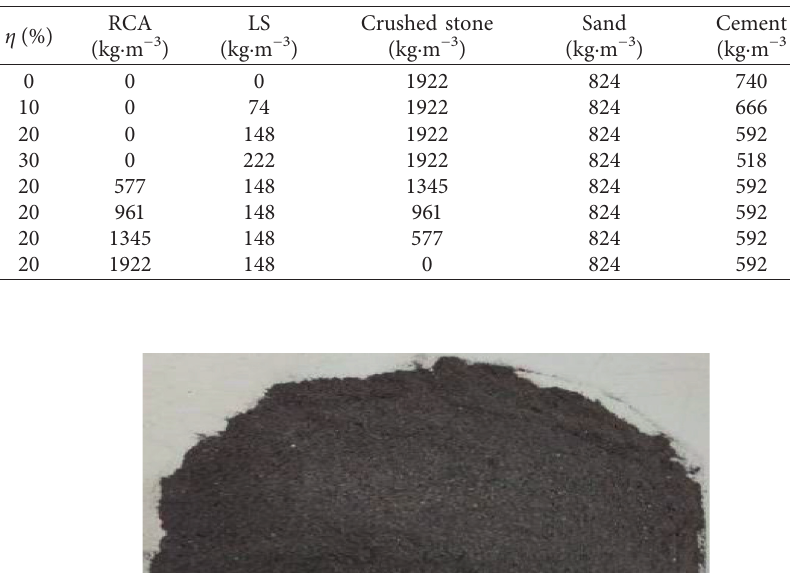
Table 1: Details of all specimens.